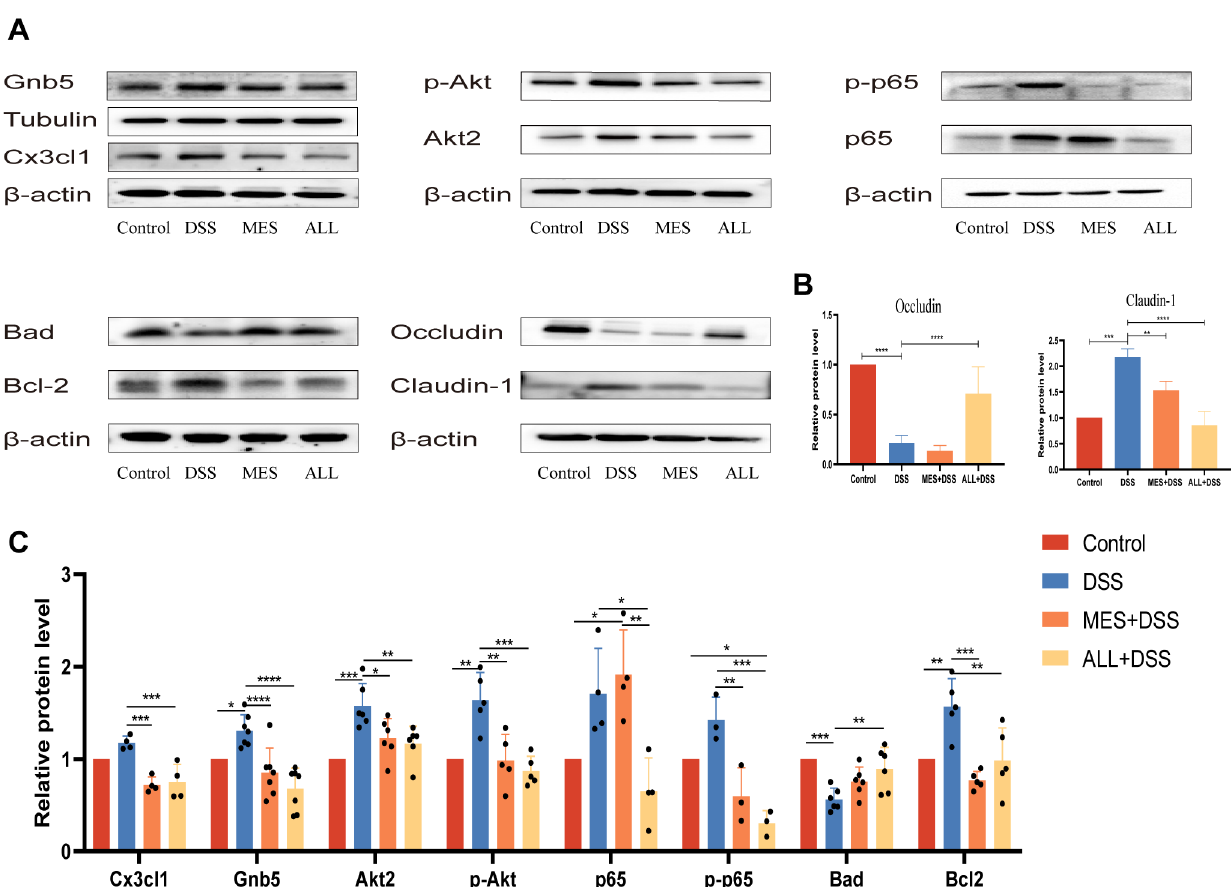
Figure 8. Effects of ALL and MES in DSS-induced mice on protein levels of Cx3cl1, Gnb5, Akt2, p-Akt, p65, p-p65, Bad, Bcl-2, occludin, and claudin-1. Proteins were determined by Western blot, grayscale analysis was performed using Image J, and relative protein content was calculated; the measured data were expressed as mean ± SD (ratio to β -actin/Tubulin) and analyzed by one-way ANOVA. * p < 0.05, ** p < 0.01, *** p < 0.001, and **** p < 0.0001. All trials were repeated at least three times.